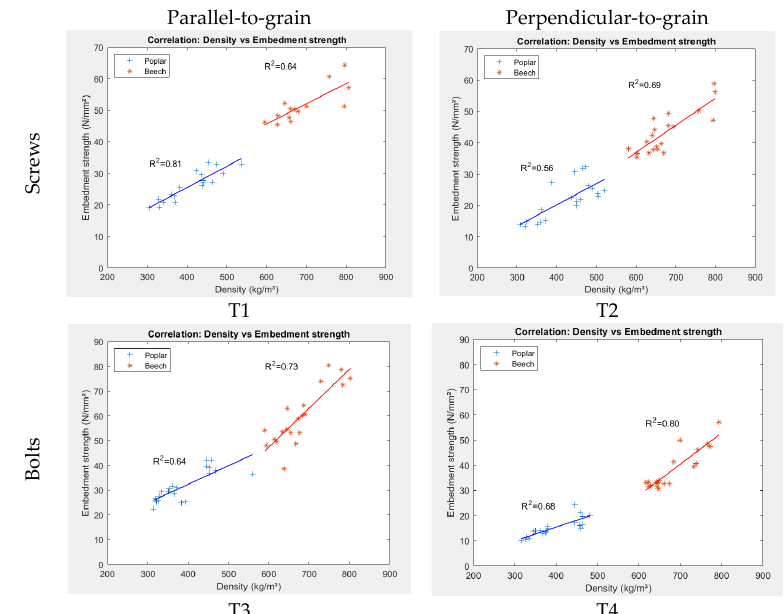
T4 ) and embedment strength ) diagram. ( T1 ) screw Figure 13. Correlation between density ( Figure 13. Correlation between density ( ρ 12 ) and embedment strength ( f h , exp ) diagram. (T1) screw ø ø 9 mm ( T2 ) screw ø 9 mm ( T3 ) bolt ø 12 mm ( T4 ) bolt ø 12 mm. 𝜌𝜌 12 ( 𝑓𝑓 ℎ , 𝑒𝑒𝑚𝑚𝑒𝑒 9 mm; (T2) screw ø 9 mm; (T3) bolt ø 12 mm; (T4) bolt ø 12 ; ; ;